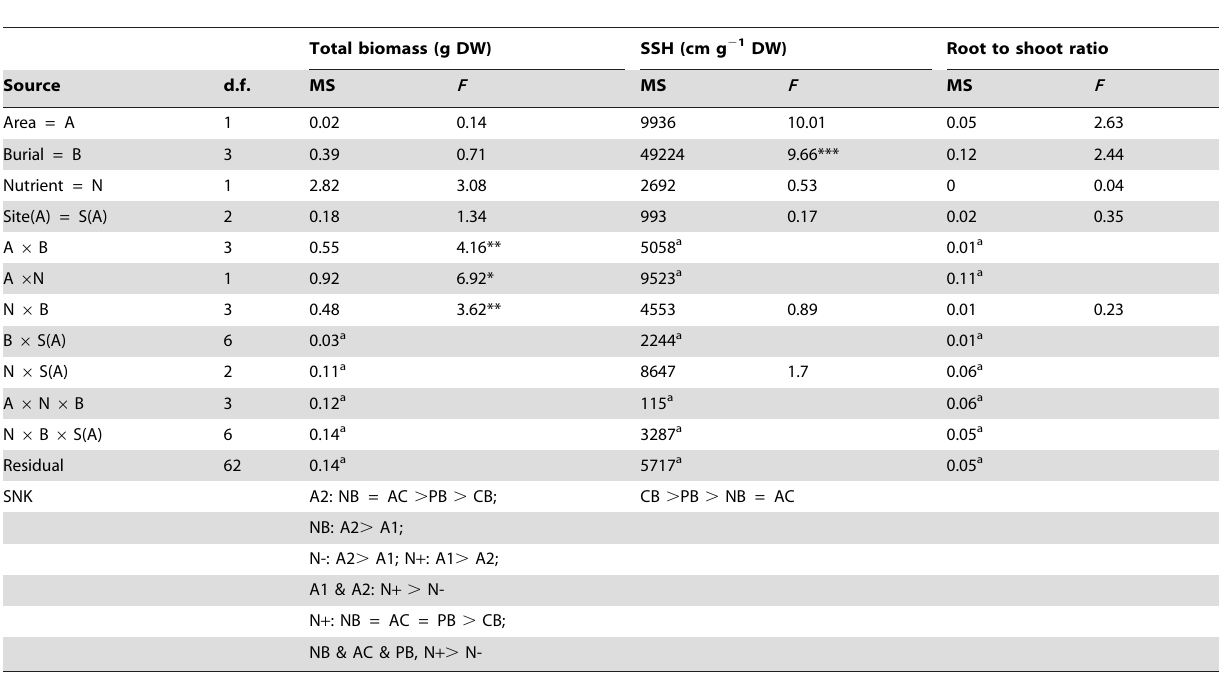
Table 2. ANOVAs for the effects of area, site, burial height, nutrient availability and their interactions on total biomass, specific shoot height (SSH) and root to shoot ratio of Sporobolus virginicus